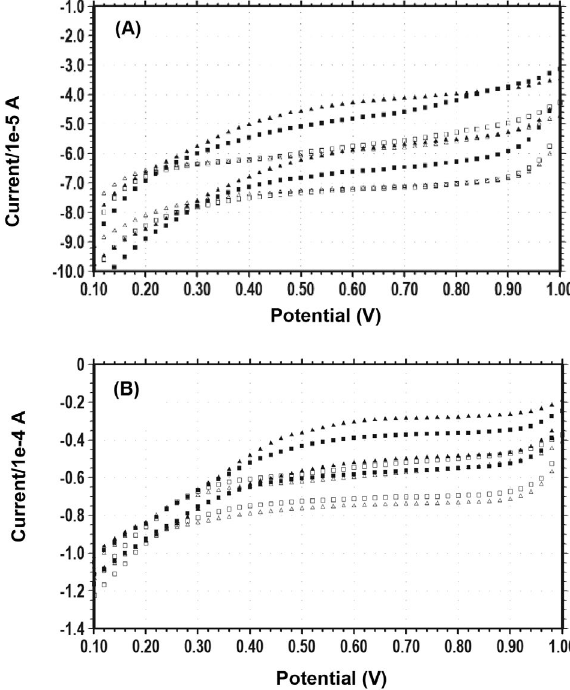
Figure 7. Cyclic voltammograms of nanoparticle free enzyme elec- trode in the buffer (  ) and in the glucose solution (  ), cyclic voltammograms of ZnONP containing enzyme electrodes in the buffer (  ) and in the glucose solution (  ) for PPy (A) and for POA (B) (5 mM glucose